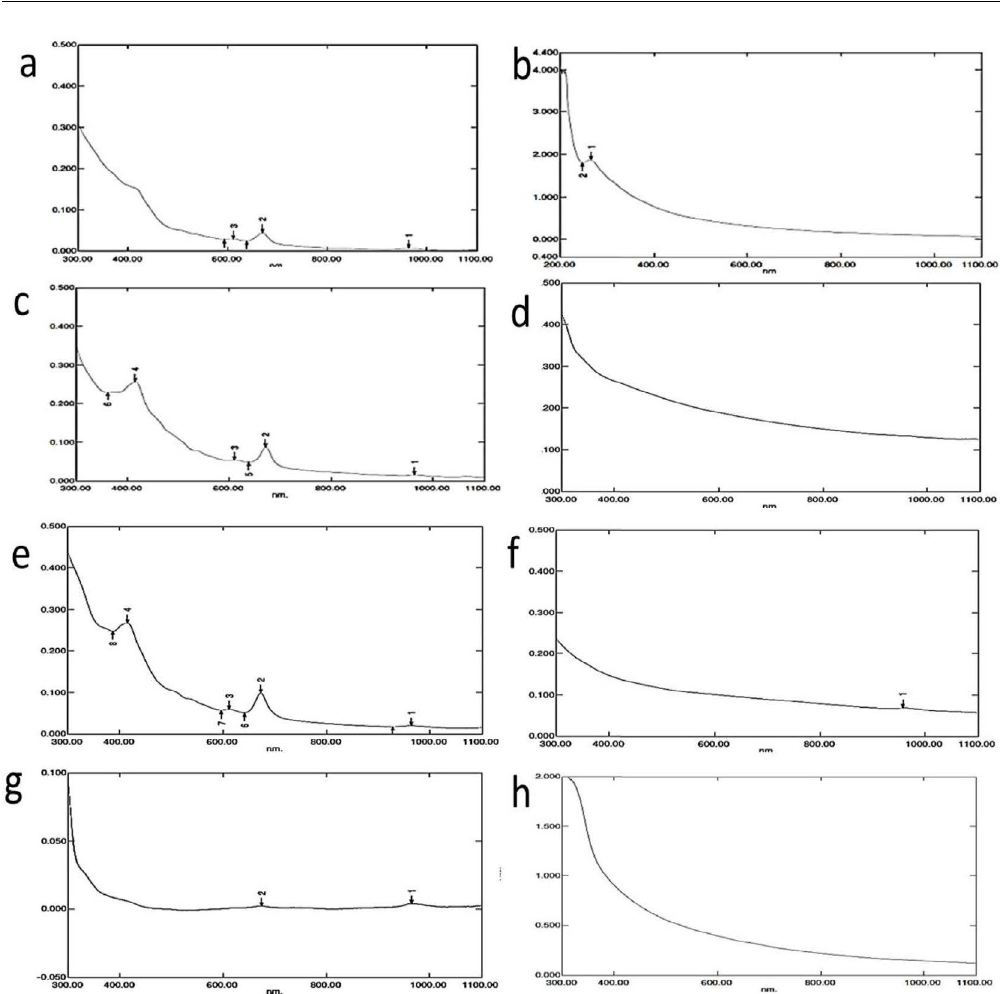
Fig. 7. UV-visible spectroscopy analysis of silver nanoparticles a ) Saraca indica (ethanol) b ) Saraca indica (water) c ) Annona recticulata (ethanol) d ) Annona recticulata (water) e ) Datura metel (ethanol) f ) Datura metel (water) g ) Aegle marmelos (ethanol) h ) Aegle marmelos